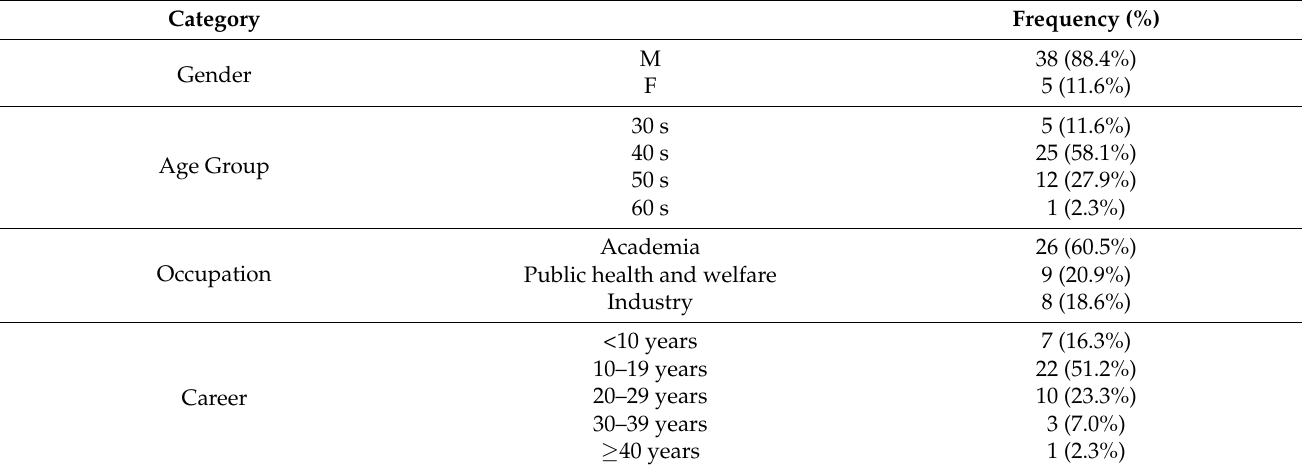
Table 4. Participants sociodemographic characteristics (Unit: n, %).